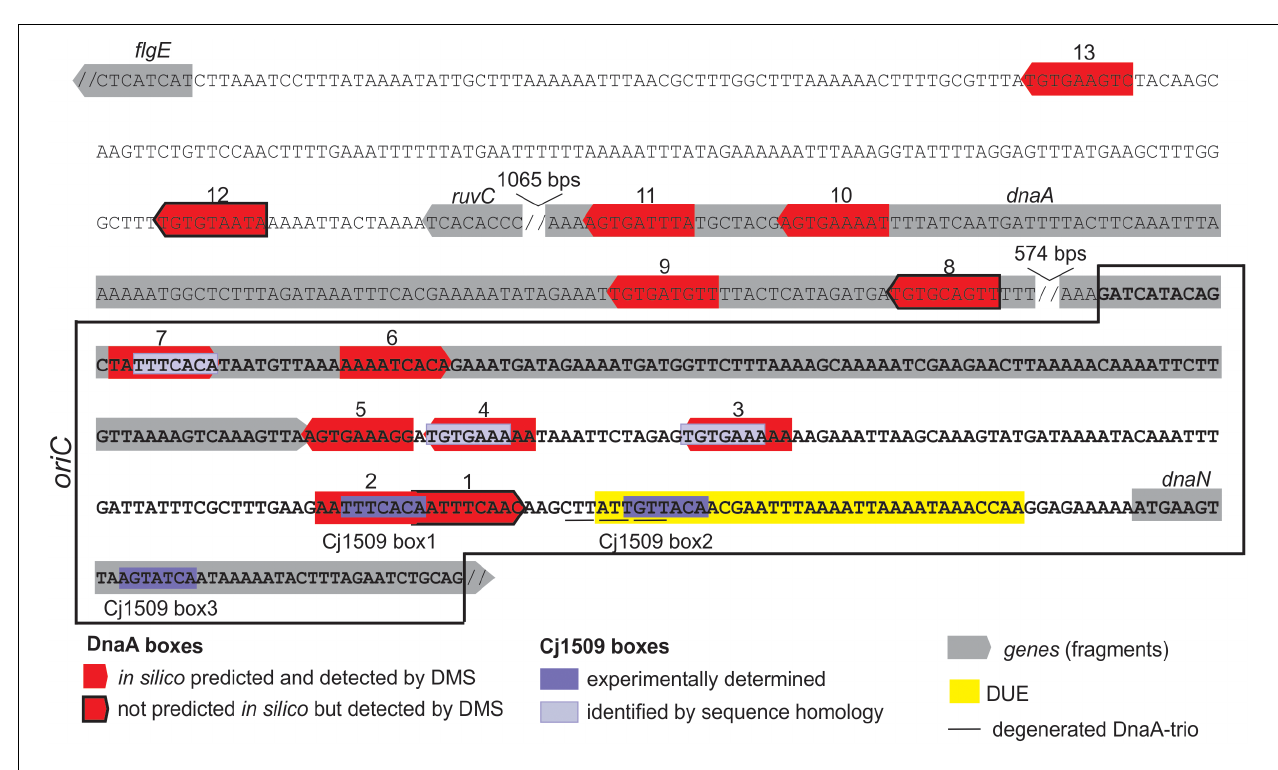
FIGURE 7 | Summary of the most characteristic features identified by DMS, P1 nuclease and minichromosome maintenance assay in C. jejuni oriC . The minimal sequence sufficient to support autonomous replication of the minichromosome is boxed. The discontinuity of the DNA sequence is marked by a double slash.